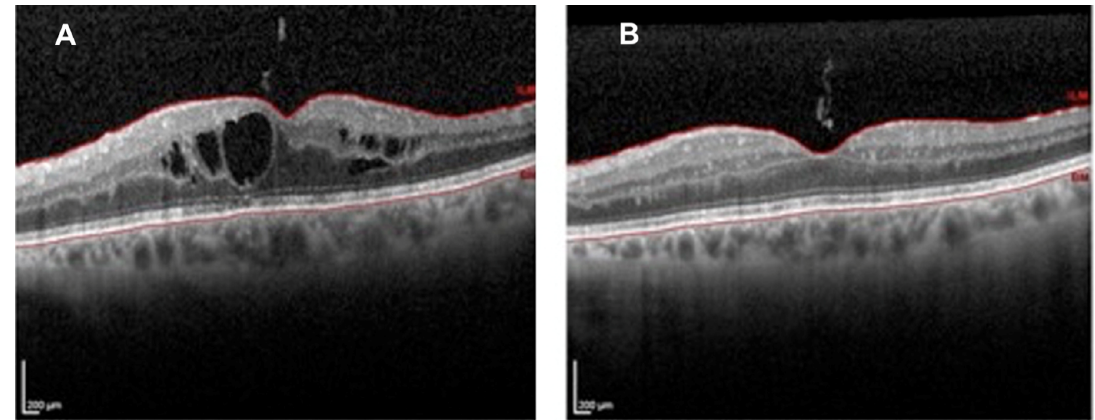
Figure 10. Macular OCT scans of radiation maculopathy before ( A ) and after ( B ) intravitreal treatment by dexamethasone implant: Complete resolution of macular edema was documented two months after treatment.